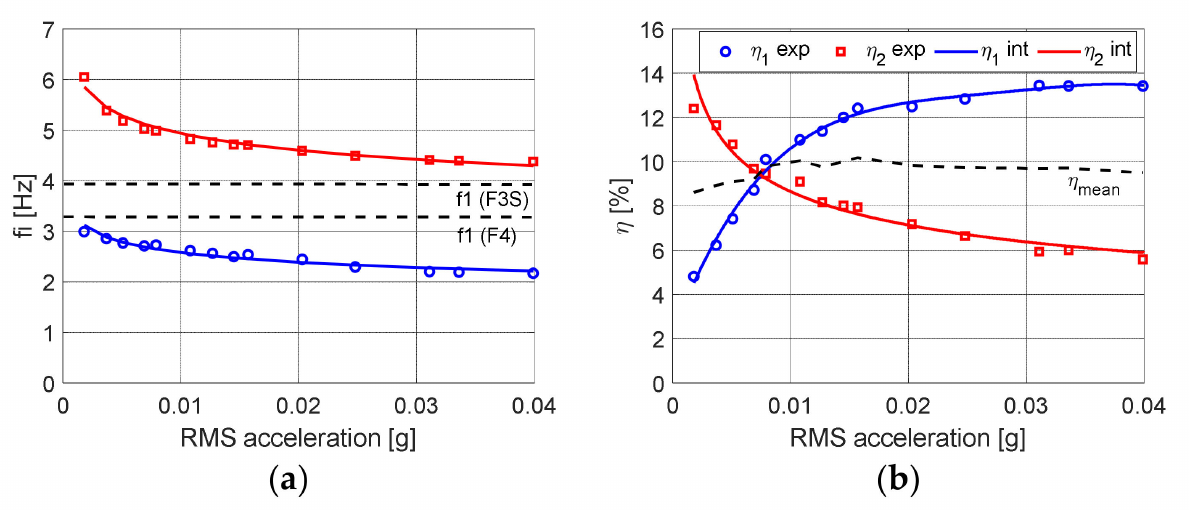
Figure 10. ( a ) First two identified frequencies for FTMD configuration versus the RMS of the base excitation (experimental values and interpolating curves), dotted lines: first frequency of F3S and F4 configuration, respectively, ( b ) first two identified damping factors for FTMD configuration versus the RMS of the base excitation (experimental values and interpolating curves), dotted line: value of the first two identified damping factors versus the RMS of the base excitation.